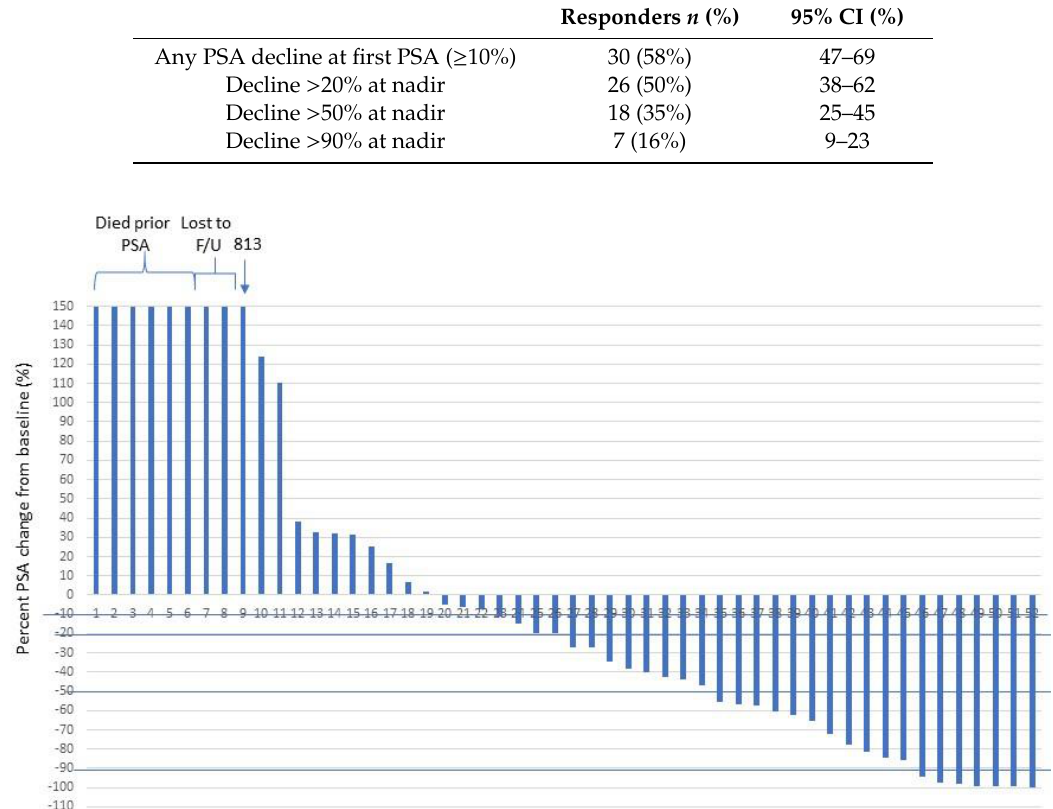
Figure 1. Percent change in PSA at nadir relative to baseline PSA (prior to first treatment).